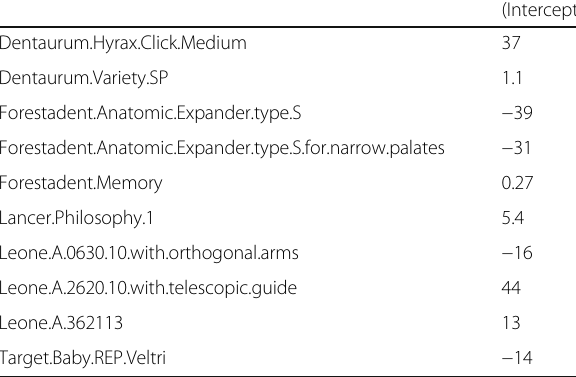
Table 5 Model-specific intercept